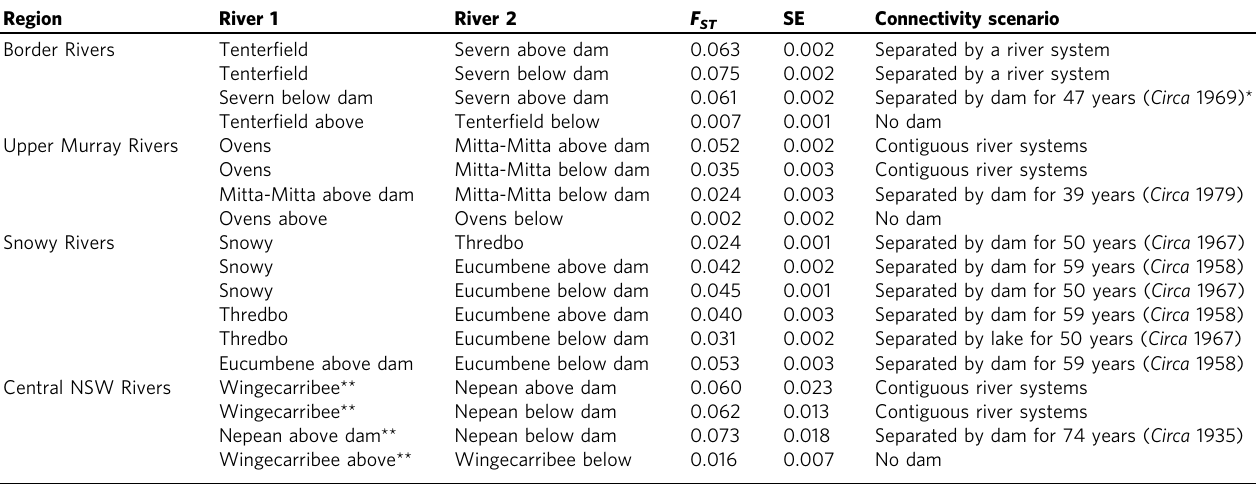
Table 2 Genetic differentiation ( F ST ) between rivers in different connectivity scenarios. Region